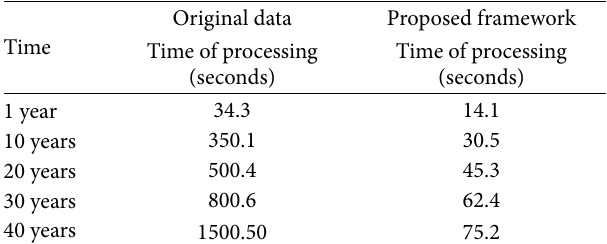
Table 5: The comparison between time processing of the data (seconds) and a different period of times.